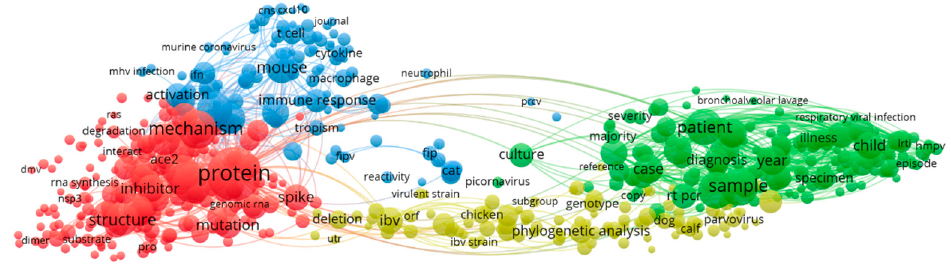
Figure 6. 2008 – 2011 term co-occurrence map.